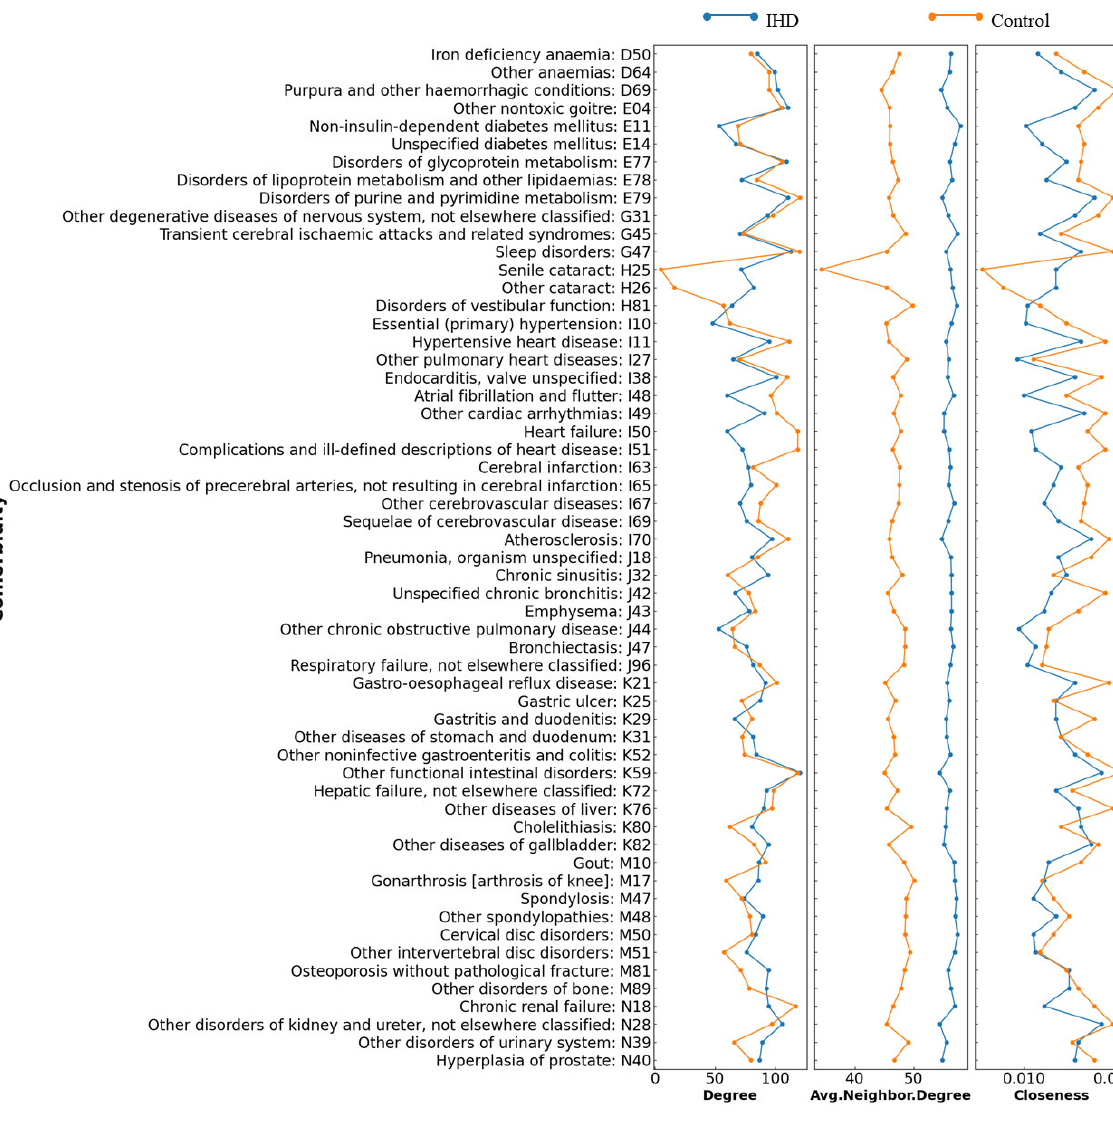
Figure 3. Three centrality measures visualized for IHD patients and